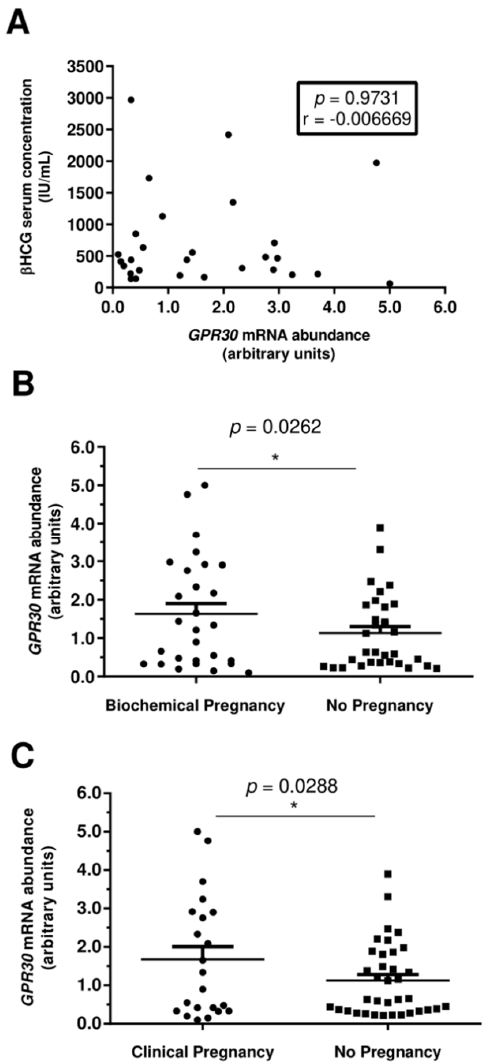
Figure 4. The association between GPR30 mRNA abundance in spermatozoa and pregnancy. The